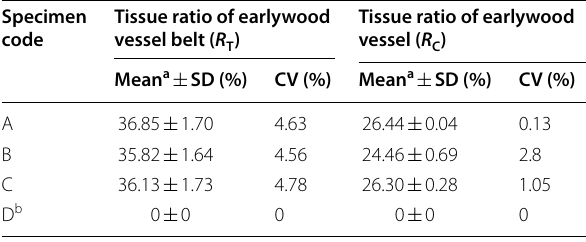
a Mean is for repeated specimens. CV is coefficient of variation b White oak specimen without earlywood vessel belt (the control group)